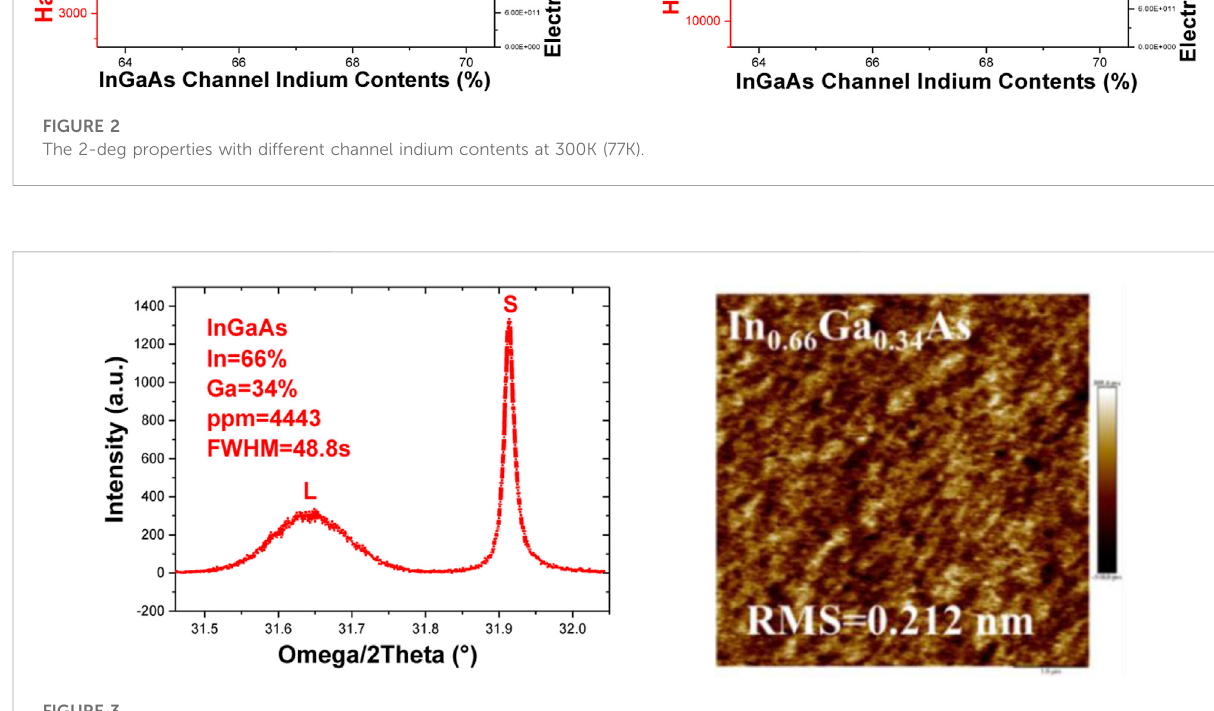
FIGURE 3 The HRXRD swing curve and the AFM images of In 0.66 Ga 0.34